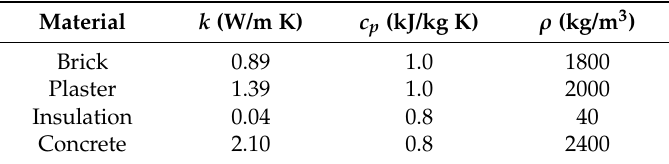
Table 3. Properties of structural